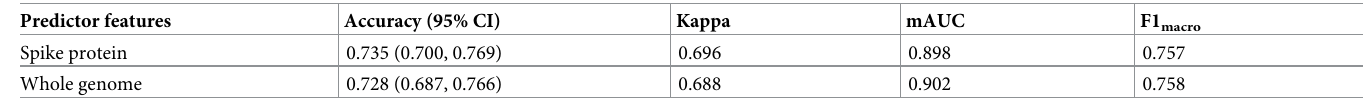
Table 2. Predictive performance of random forest models. Model diagnostics describing overall performance when applied to predict host category of held-out corona- viruses not used for model training. CI denotes confidence interval, Kappa denotes Cohen’s Kappa statistic, mAUC denotes multiclass area-under-curve statistic, and F1macro denotes F1 score calculated using macro-averaging (performance on each host category weighted equally).